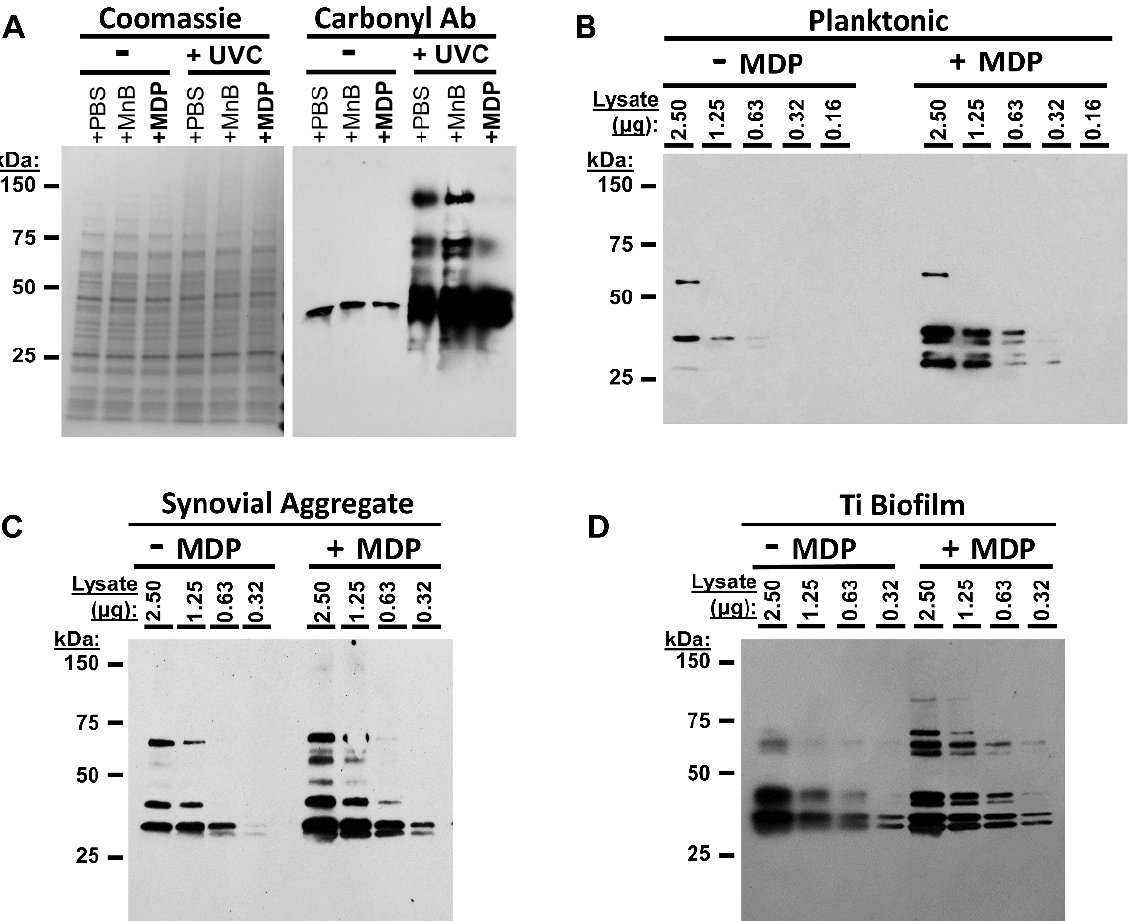
Figure 3. MDP protects MRSA proteins during UVC irradiation. ( A ) MDP protects proteins from oxidation. Planktonic MRSA were prepared in PBS, Mn+ buffer, or with MDP and subjected to 5 min UVC exposure or not. Lysates were prepared and analyzed via either (left) Coomassie stain (concentration control) or (right) western blot for derivatized carbonyl groups (DNP). ( B – D ) Planktonic, synovial fluid or titanium drip culture preparations of M2 were irradiated for 5 min with MDP or buffer, lysed, and remaining epitopes were analyzed via western with anti-MRSA mouse sera raised against inactivated whole-cell planktonic MRSA.